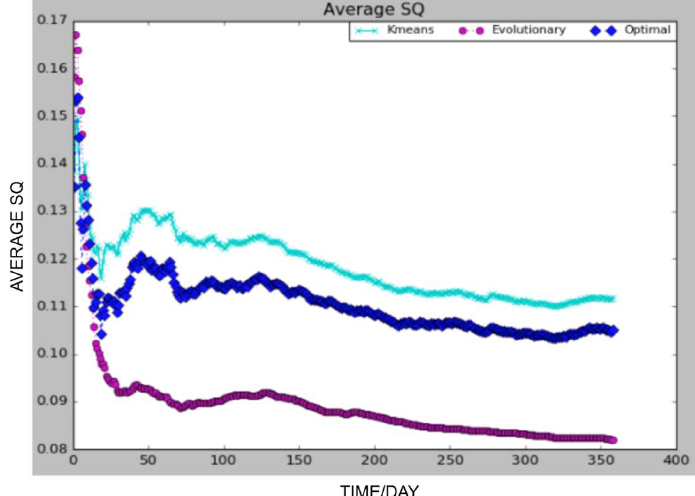
Figure 10. One-year average SQ of three algorithms in LD2011_2014 dataset.